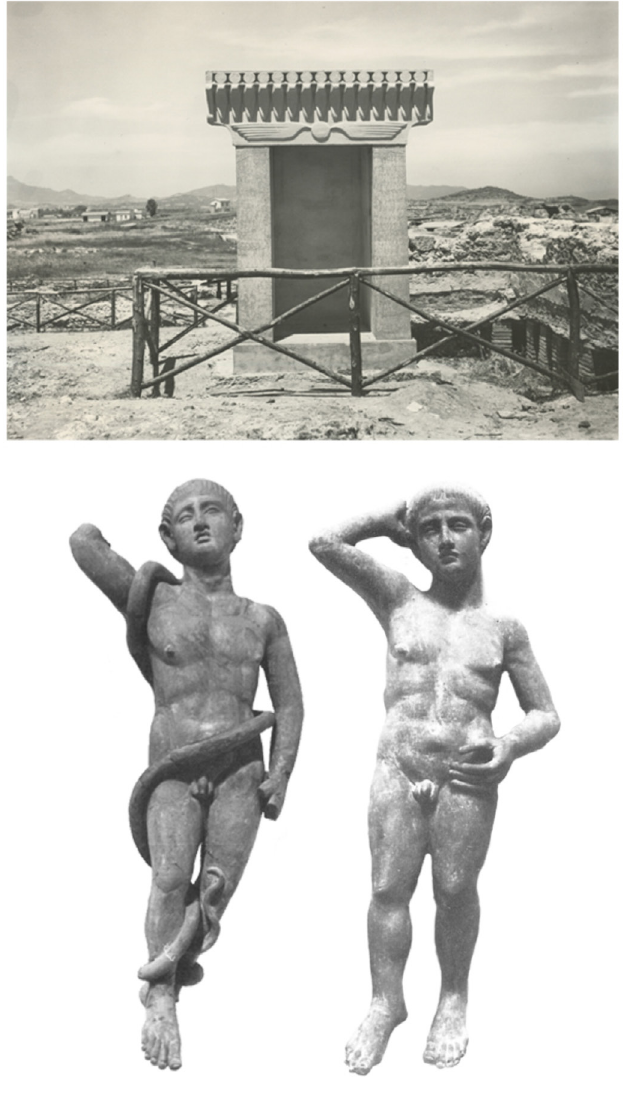
Figure 3. Reproduction of the Punic votive shrine ( maabed ) and two examples of terracotta sleeping figurines. Images: Bonetto et al., 2018; Angiolillo,